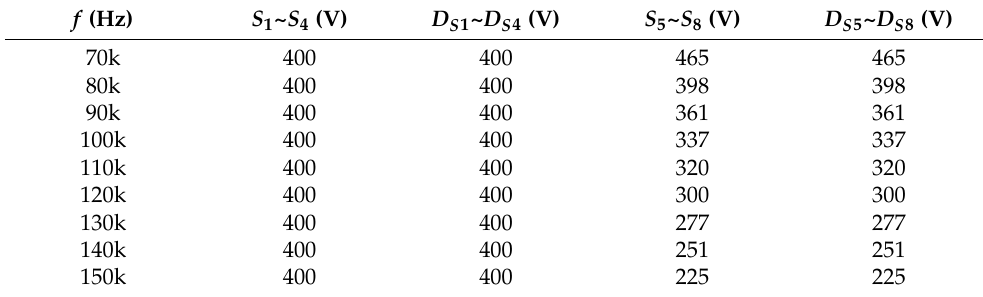
Table 3. Voltage stress of the power switches and diodes for the primary and secondary sides.